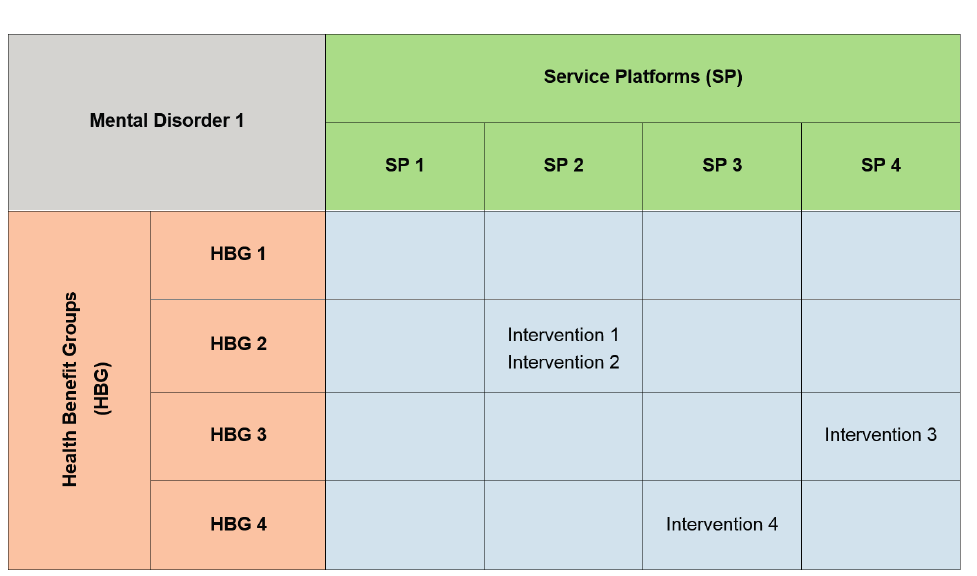
Figure 1. Mock example of a Health Benefit Group/Service Platform